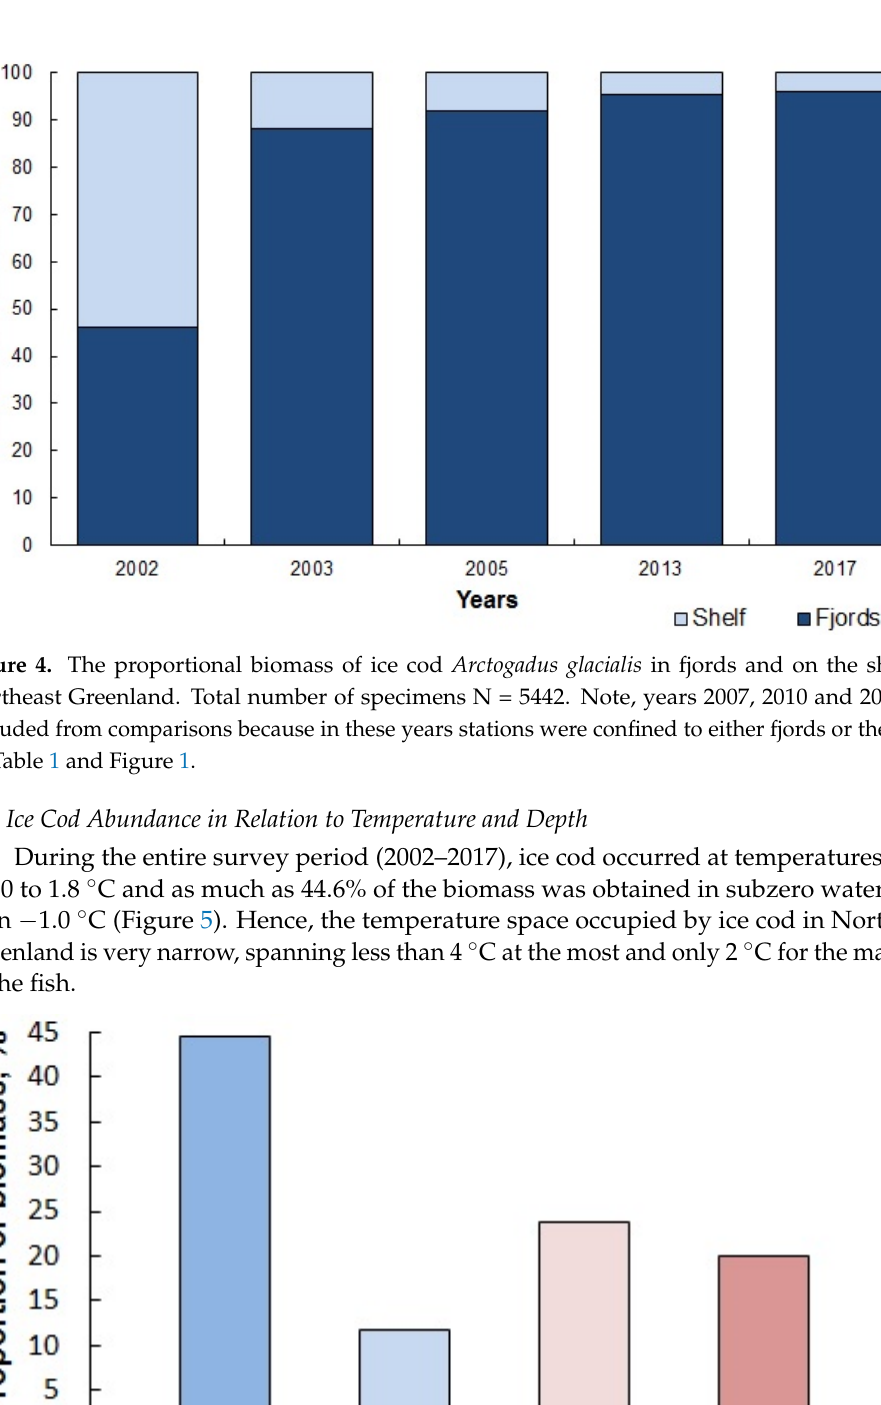
Figure 4. The proportional biomass of ice cod Arctogadus glacialis in fjords and on the shelf in North ‐ east Greenland. Total number of specimens N = 5442. Note, years 2007, 2010 and 2015 are excluded from comparisons because in these years stations were confined to either fjords or the shelf, cf. Table 1 and Figure 1.